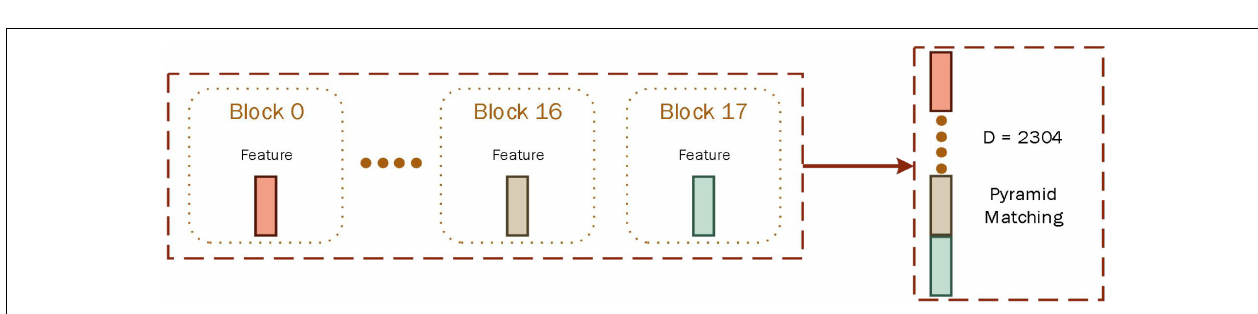
Frontiers in Marine Science |